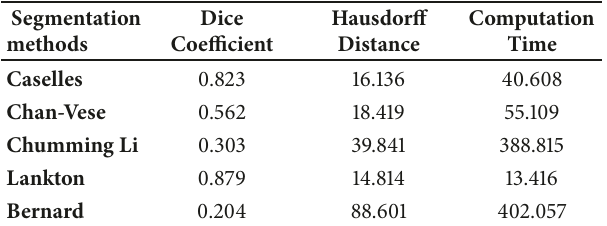
Table 1: Performance metrics value for several segmentation meth-